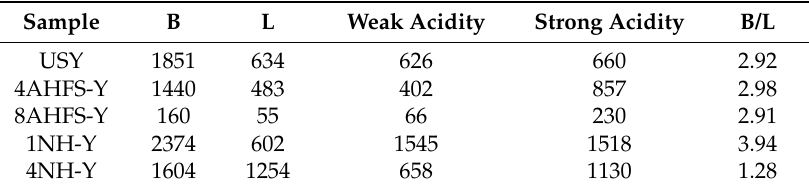
Figure 1. NH 3 -TPD profiles of AHFS- and alkaline-treated USY. Table 2. Acidity properties of samples ( μ mol/g).